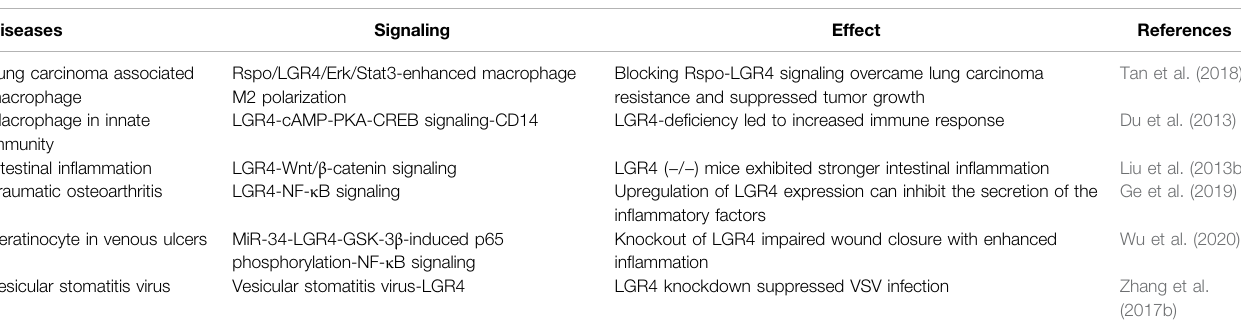
TABLE 2 | The functions of LGR4 in immune-related